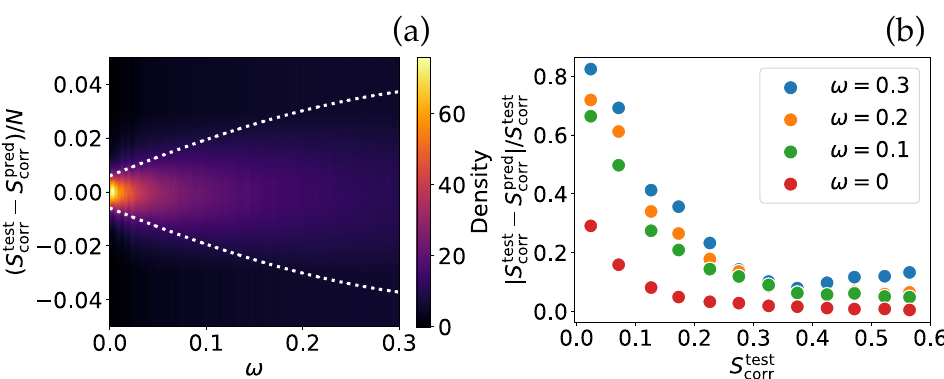
Figure 5: Performance of the neural network model in the presence of strong noise.(a) Probability distribution of the error in the prediction in the presence of noise. (b) Mean absolute percentage error (MAPE) as a function of the degree of correlation. The MAPE has averaged on a small range (0.05) in the values of S test